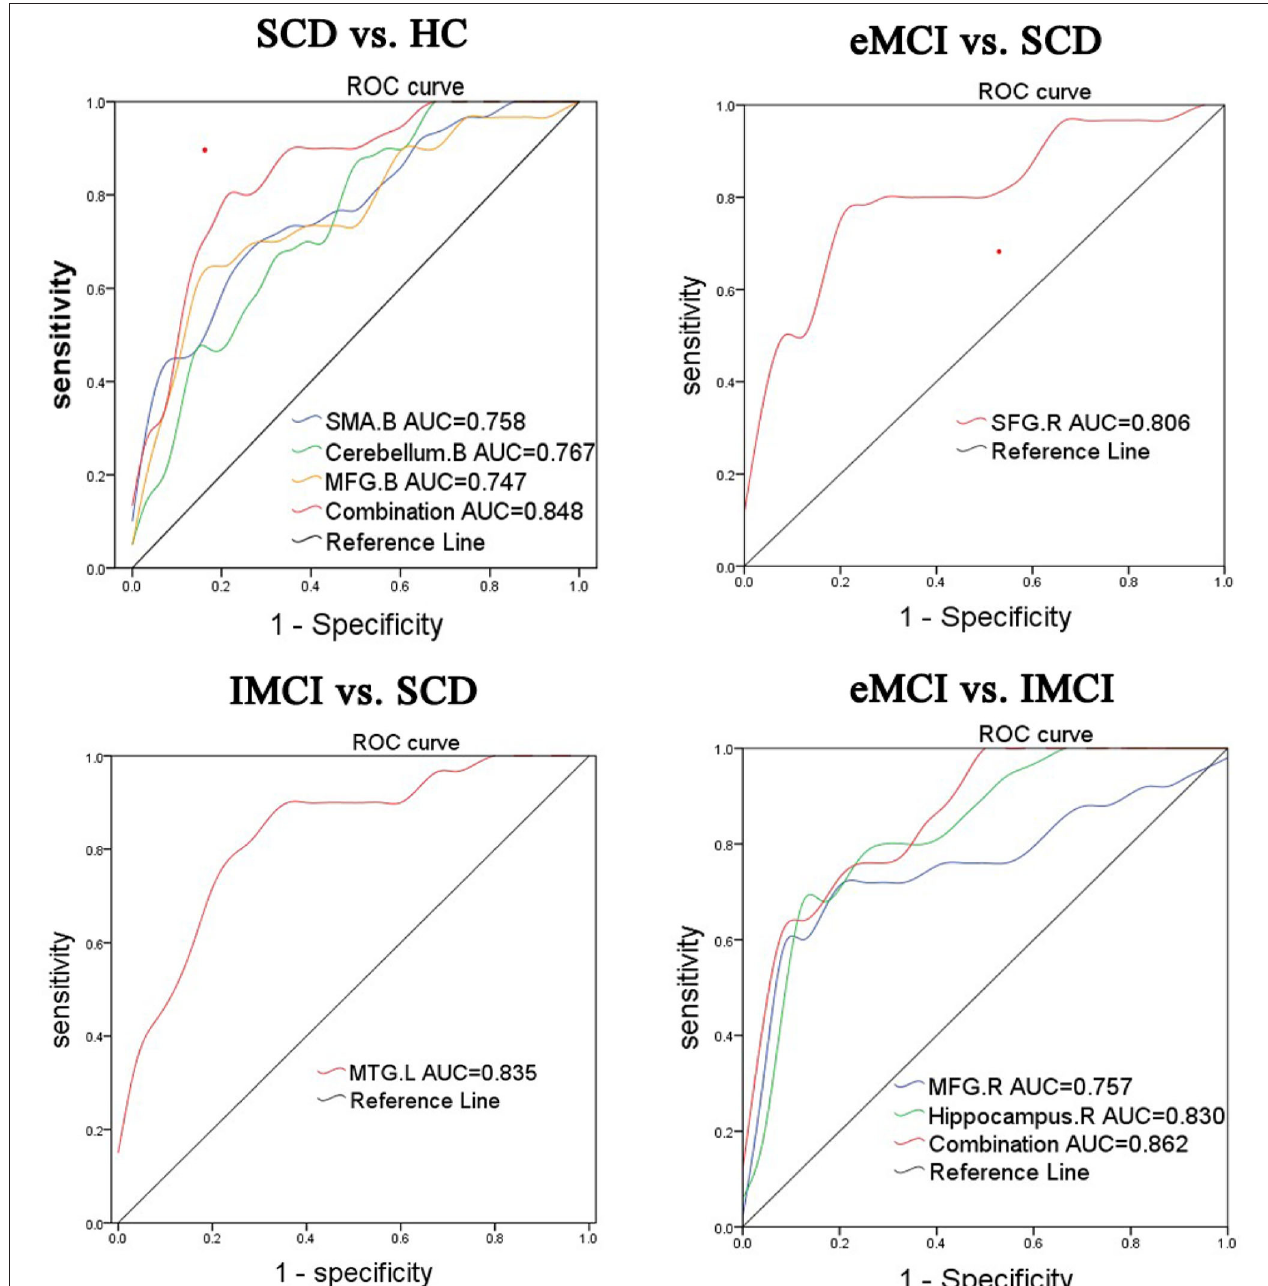
FIGURE 3 | Receiver operating characteristic (ROC) curves of different groups were identified in specific brain areas. eMCI, early mild cognitive impairment; lMCI, late mild cognitive impairment; SCD, subjective cognitive decline; HC, healthy controls; SMA, supplementary motor area; SFG, superior frontal gyrus; MFG, middle frontal gyrus; MTG, middle temporal gyrus; L, left hemisphere; R, right hemisphere; B, bilateral